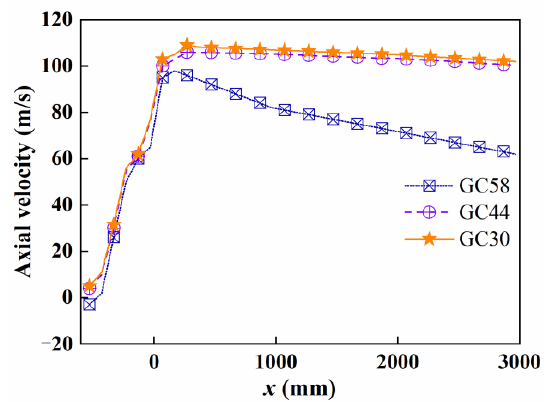
Figure 7. The axial velocity along central axis.